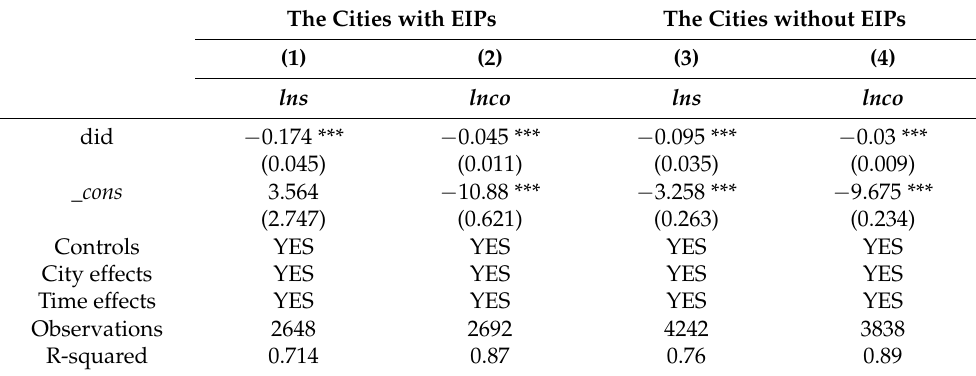
Table 9. Provincial DZs to